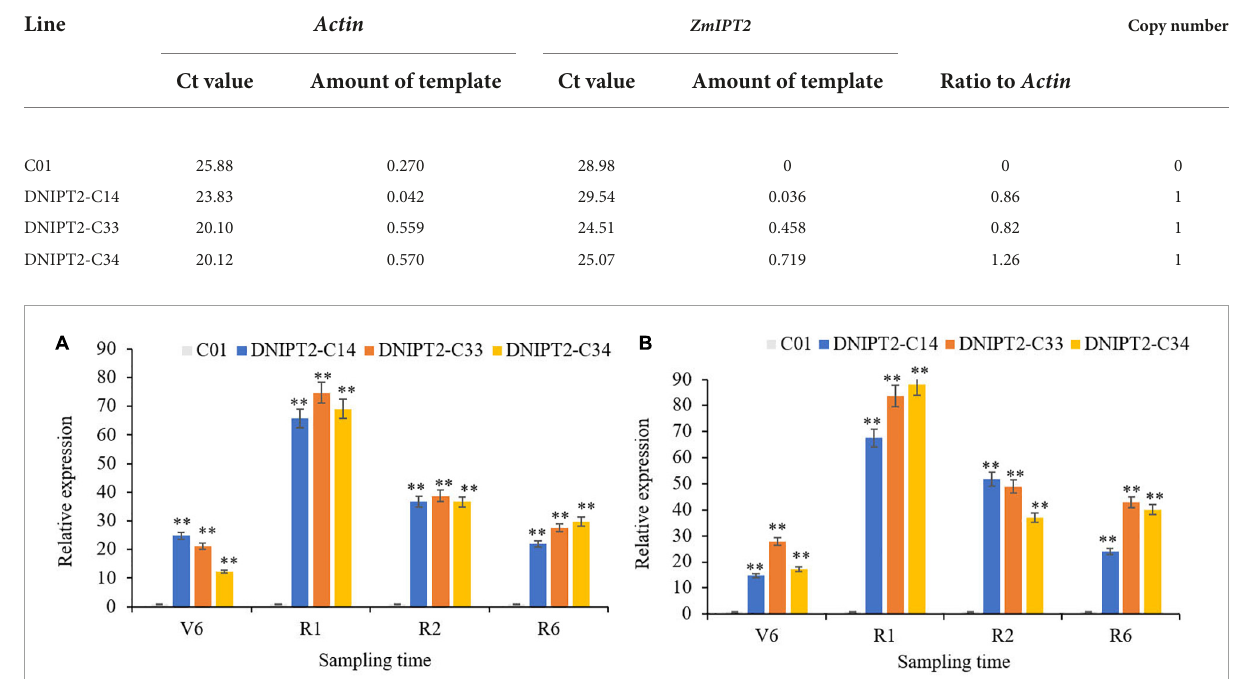
TABLE 2 Copy number of ZmIPT2 gene in trangenic lines.